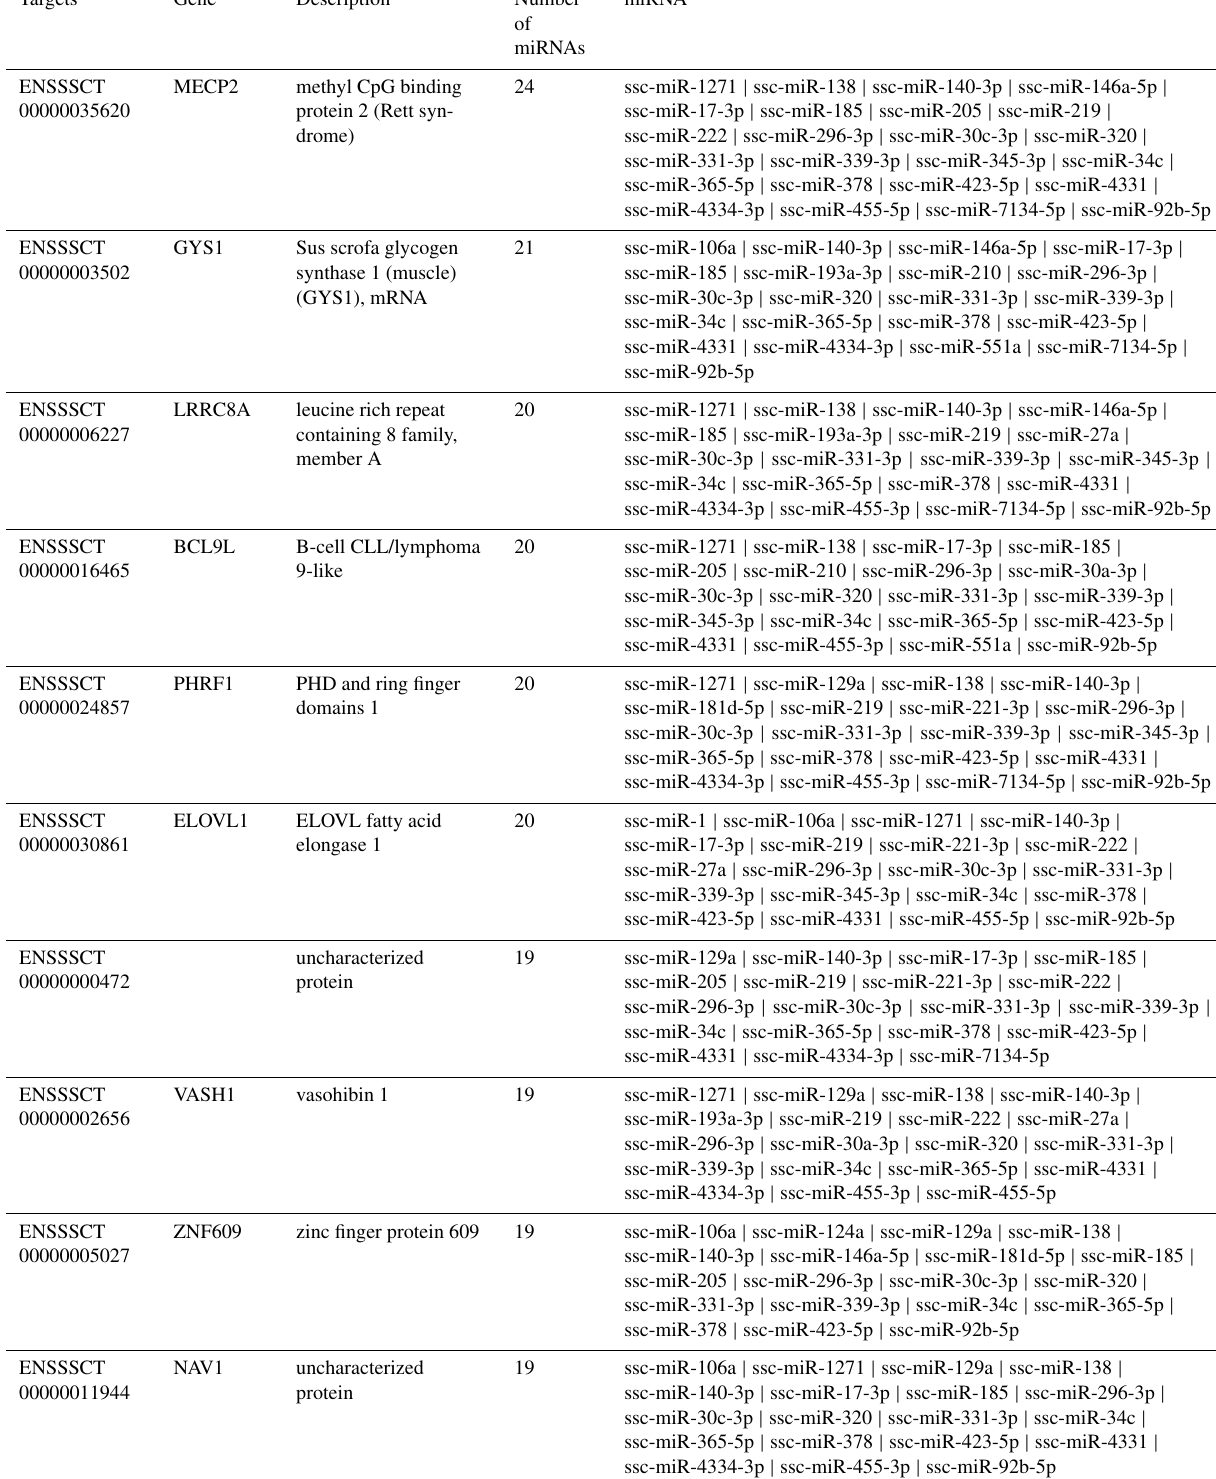
Table 5. Top 10 target genes corresponding to miRNAs.